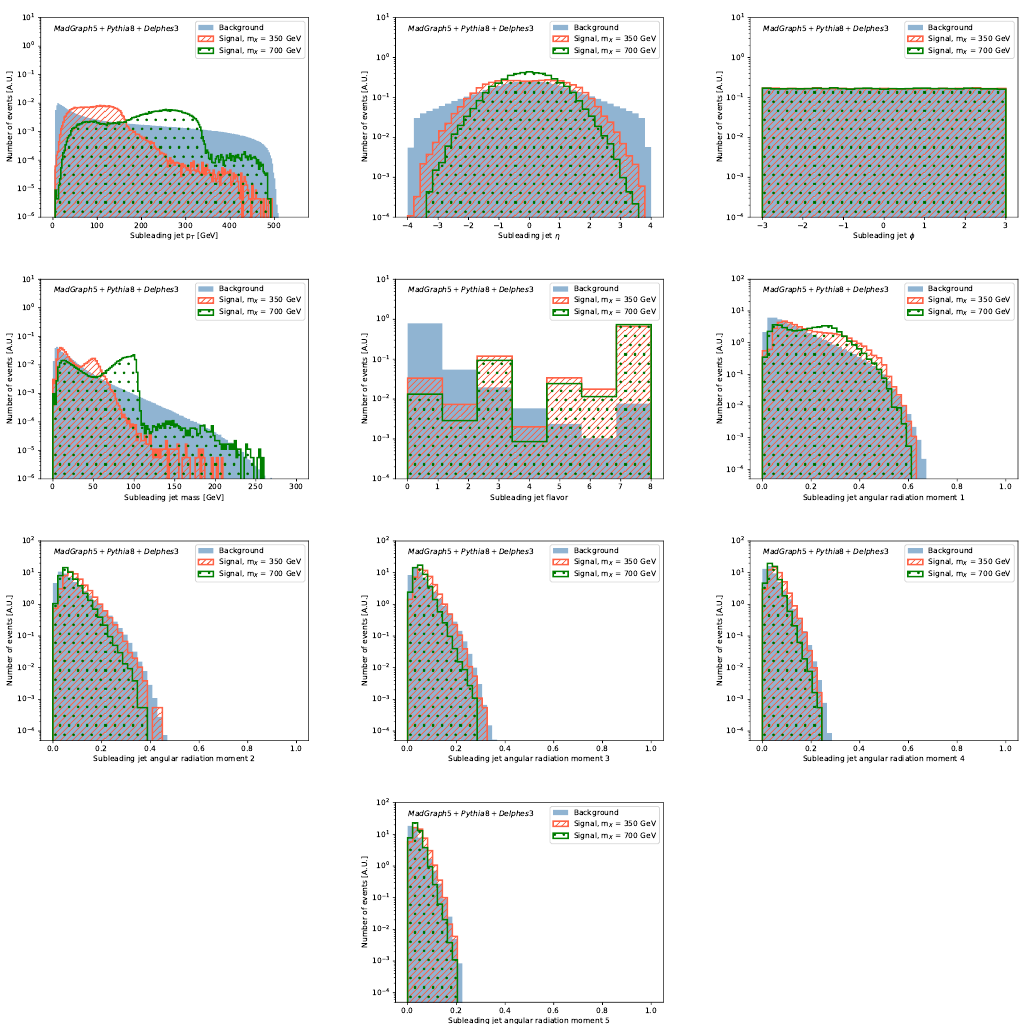
Figure 12. Subleading jet input PFN